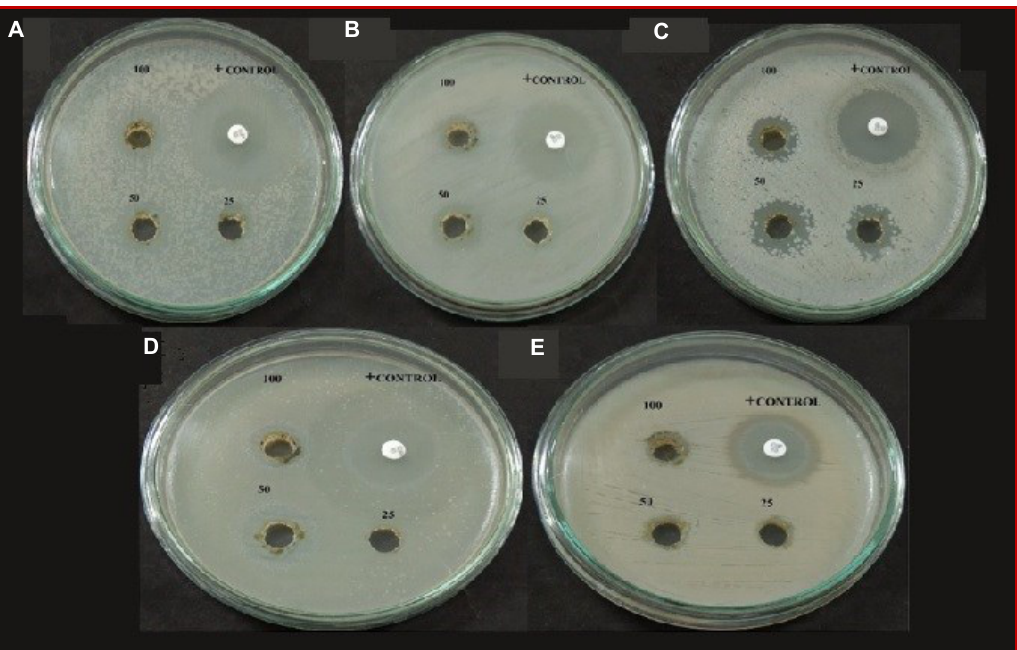
Figure 1: Antibacterial activity of ethyl acetate extract of A. versicolor leaves. Bacillus subtilis (A), Listeria monocytogenes (B), Staphy- lococcus aureus (C), Escherichia coli (D), Klebsiella pneumoniae